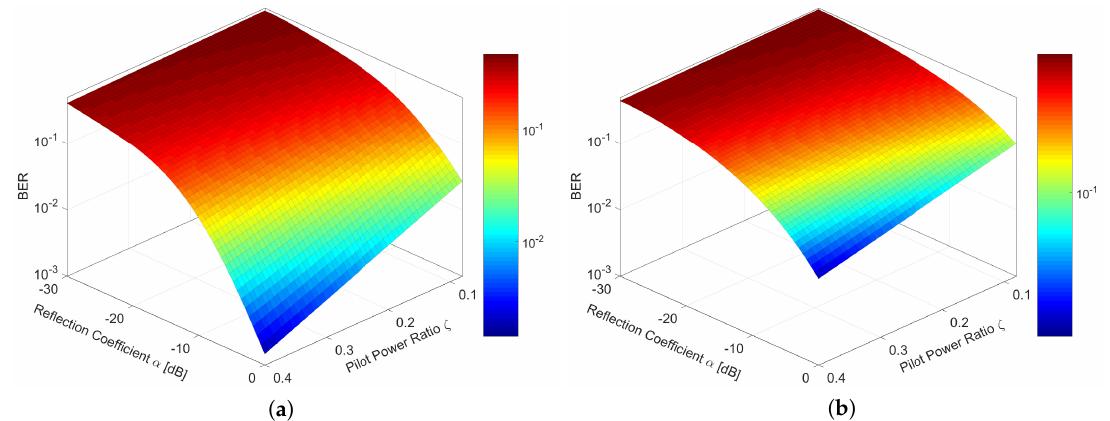
Figure 10. Effect of the pilot power ratio ζ and the reflection coefficient α for detection performance at the reader. (If ζ 0.08, equal power is allocated among data and pilot subcarriers). ( a ) BER performance in MSC-AmBC ( K = 10, K 1 = 3, M = 2). ( b ) BER performance in TD-AmBC ( K = 10, K 1 = 1, M =